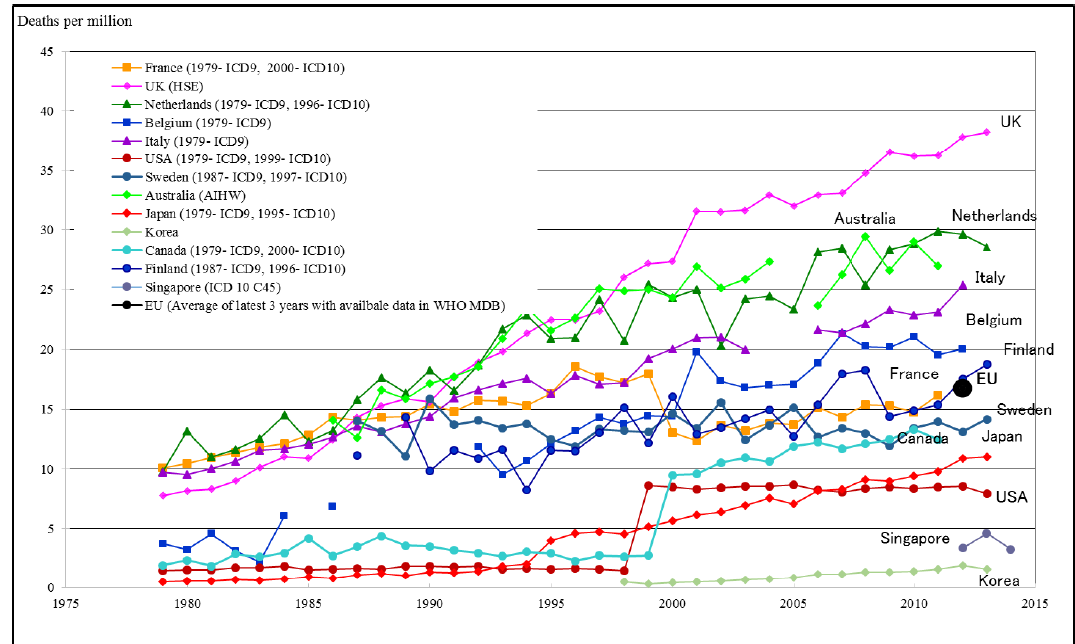
Figure 2. Mesothelioma death rate for selected countries. WHO Mortality Database, ICD 10: C45 Mesothelioma, ICD 9: 163 Malignant Neoplasm of Pleura; UK: Health and Safety Executive Statistics—Mesothelioma, http://www.hse.gov.uk/statistics/causdis/meso.htm; Australia: National Cancer Statistics Clearing House of Australian Institute of Health and Welfare (AIHW).